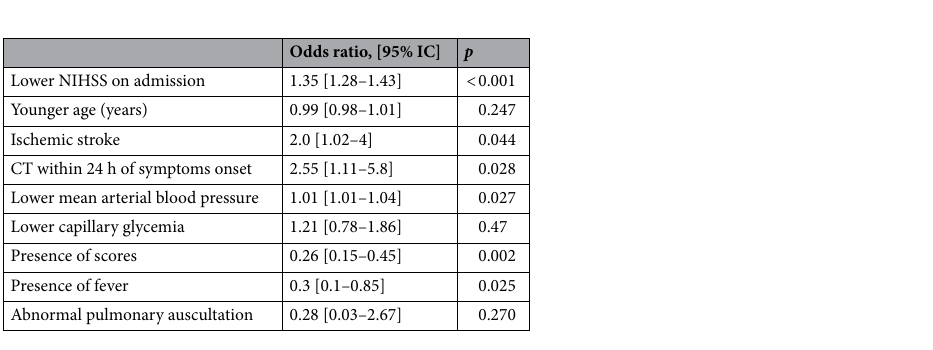
Table 2. Odd ratios of the variables assessed in the prediction model for a favorable stroke outcome (mRS ≤